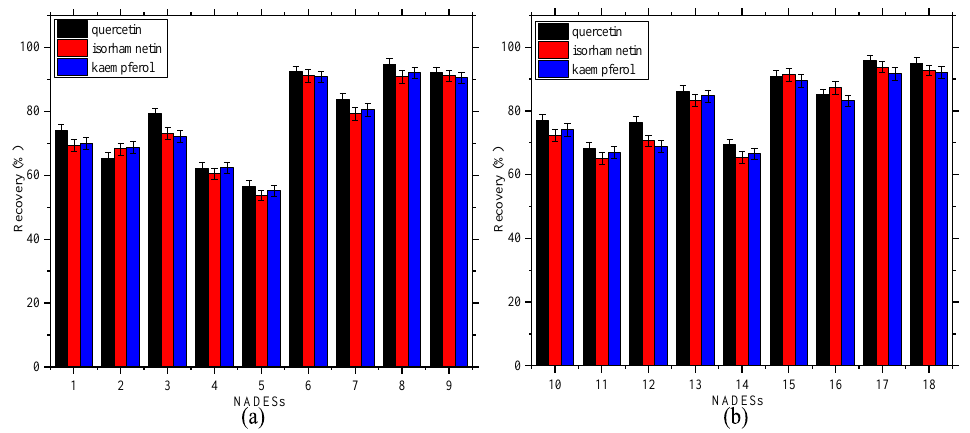
Figure 4. Selectivity of all the prepared NADESs. a : ChCl-based NADESs, and b : Bet-based NADESs.